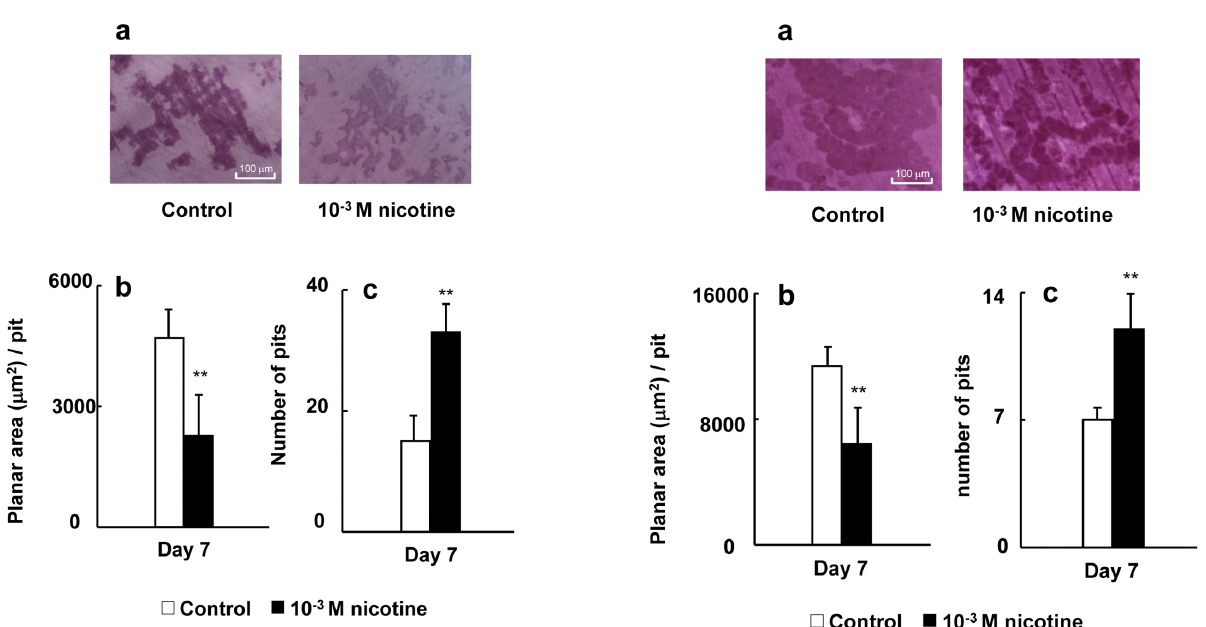
Figure 10. Effect of nicotine on pit formation. Bone marrow cells were plated onto dentin slices and cultured in medium containing macrophage colony-stimulating factor (50 ng/ml), and RANKL (50 ng/ ml) with 0 (control) or 10 2 3 M nicotine for 7 days. Representative resorption pits of control or 10 2 3 M nicotine by osteoclasts (a). The pits were quantified by tracing the perimeter of each pit to obtain the mean planar pit area under each condition. The histogram shows the average planar area of each pit under the control or 10 2 3 M nicotine condition on day 7 of culture (b). Data are expressed as the mean 6 S.D., n=3 independent experiments, each performed using triplicate coverslips with five randomly selected osteoclasts analyzed per coverslip. ** p , 0.01 nicotine treatment vs. control. The number of pits was counted under a phase-contrast microscope on day 7 of culture (c). Data are shown as the mean 6 S.D., n=3 independent experiments, each performed using quintuplicate wells. **p , 0.01, nicotine treatment vs.